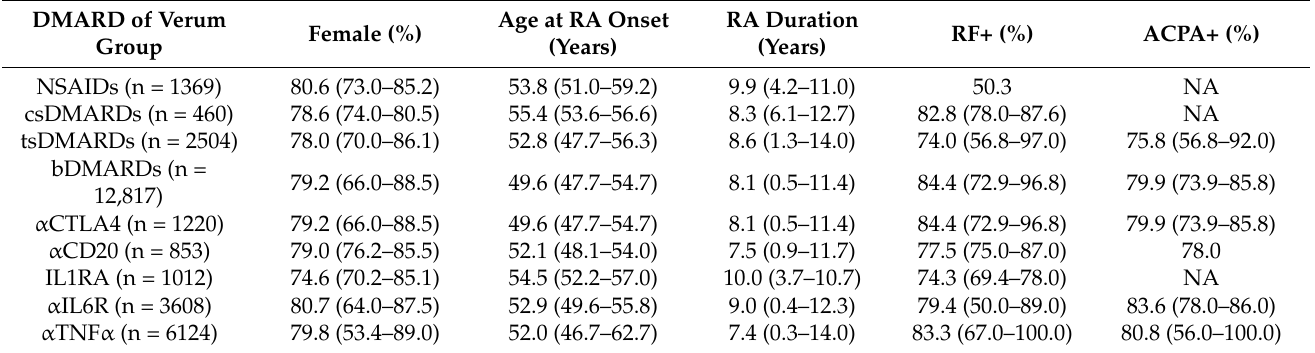
Table 1. Patients’ demographics and disease characteristics of placebo groups according to the study of verum medication.